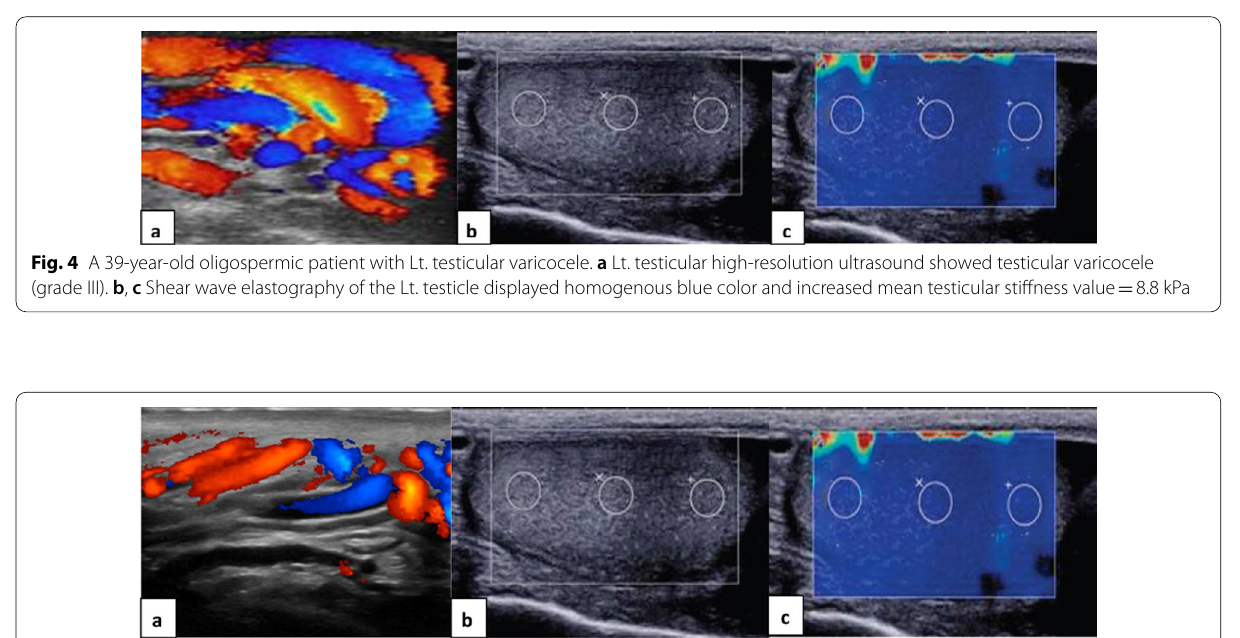
Fig. 5 A 36-year-old patient with Lt. testicular varicocele and normal total sperm count. a Lt. testicular high-resolution ultrasound showed testicular varicocele (grade II). b , c Shear wave elastography of the Lt. testicle displayed homogenous blue color and increased mean testicular stiffness value 6.8 kPa =